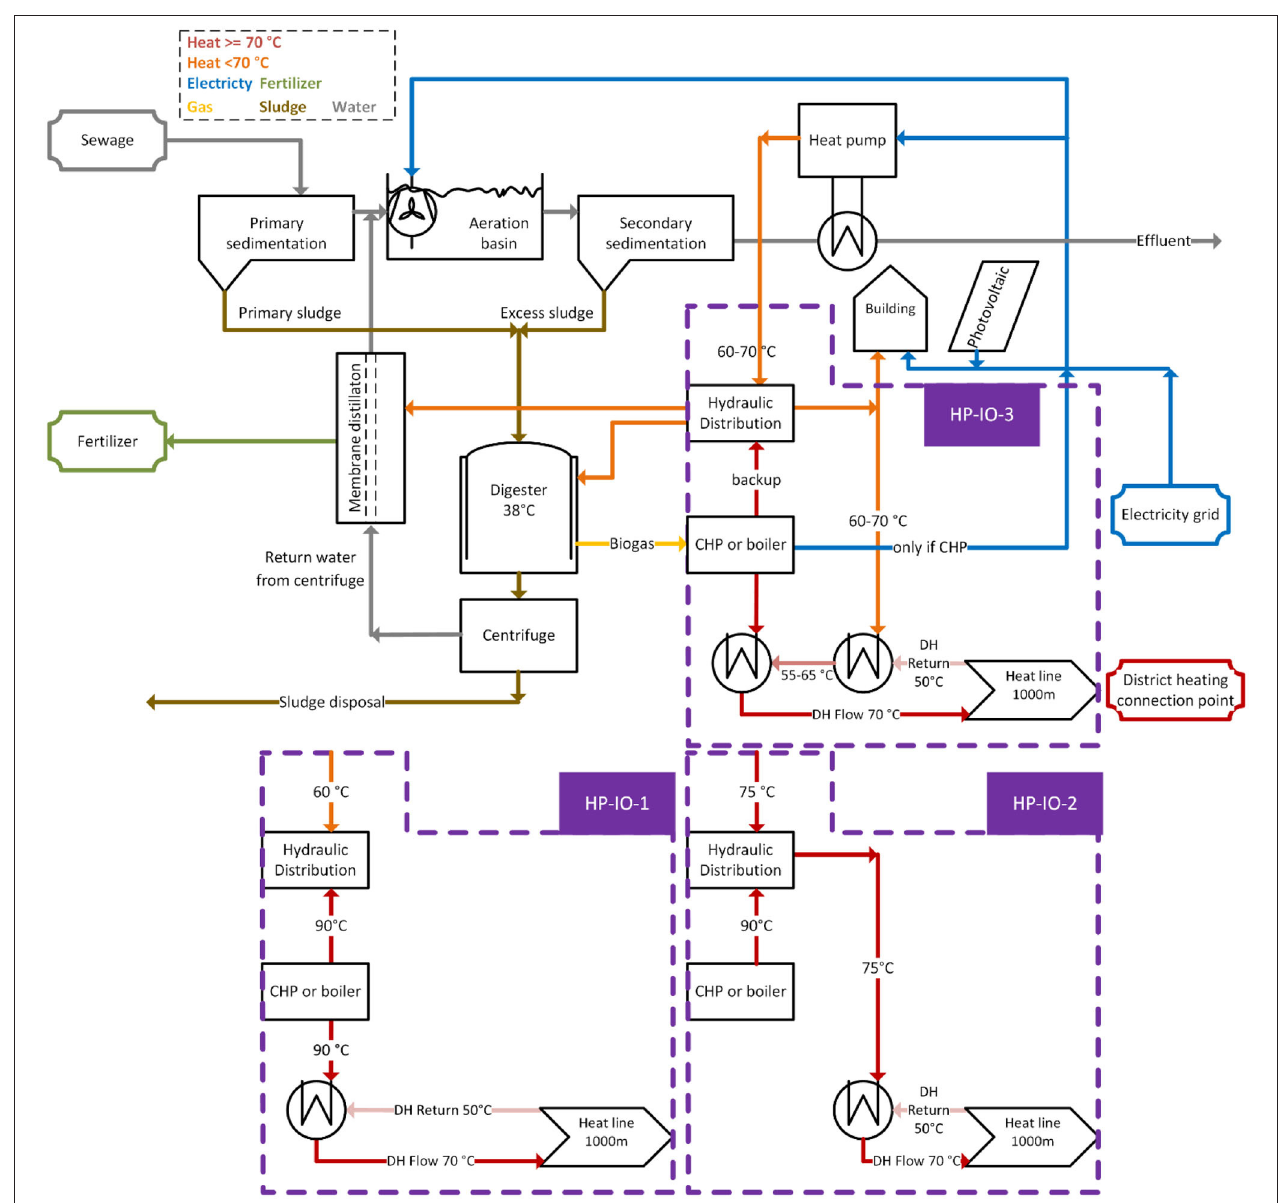
FIGURE 4 | Flow sheet of the WWTP Gleisdorf with three heat pump integration options (HP-IO) and the corresponding usage of thermal heat from a CHP or biogas boiler (own drawing). HP-IO-1 HP for internal heat demand only, thus 60 ◦ C is sufficient. Heat from CHP/boiler covers remaining internal heat demand and provides rest to heat connection line. HP-IO-2 HP provides 75 ◦ C and can thus provide heat to internal and external heat demands. HP-IO-3 HP is operated at either 60, 65, or 70 ◦ C covering all internal heat demands and pre-heats the return of the district heat connection line to 55, 60, or 65 ◦ C. Note that only changes to HP-IO-3 are shown in the separate boxes of HP-IO-1 and-